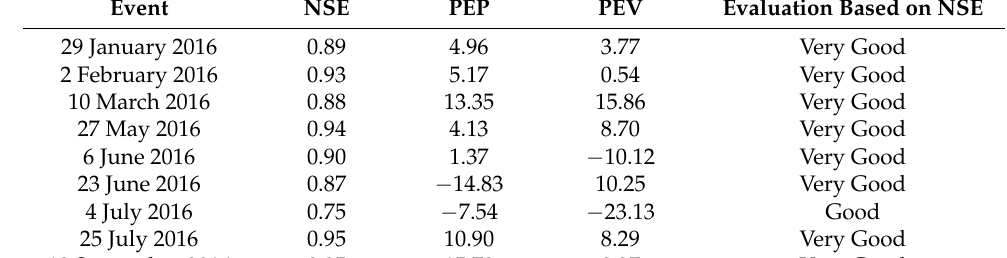
Table 4. Goodness-of-fit statistics for individual storms as extracted from the continuous runoff series. The model performance during each storm was also evaluated based on NSE values.